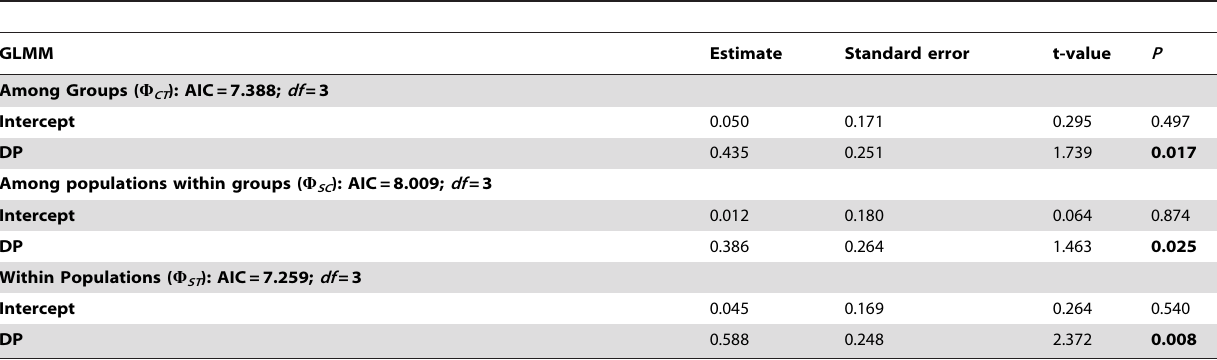
Table 5. GLMMs performed to compare species with high and low dispersal potential (DP) in AMOVA’s F statistics among groups ( W CT ), among populations within groups ( W SC ), and within populations ( W ST ).